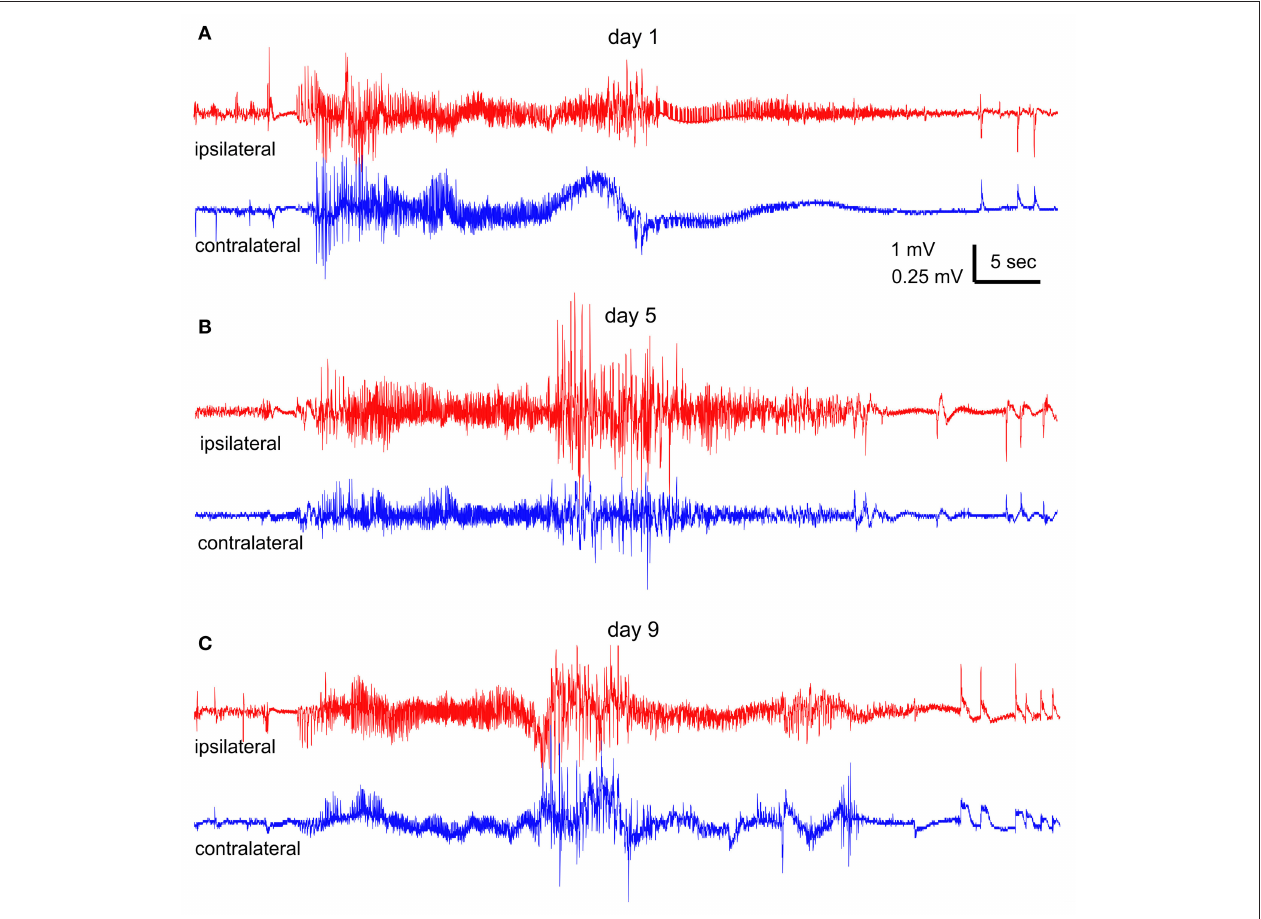
FIGURE 4 | Spontaneous hippocampal EEG discharges. Continuous EEG-webcam monitoring was conducted in an extendedly kindled mouse (#4) over 9 consecutive days. (A–C) One episode of bilateral discharges collected at the 1st, 5th, and 9th day, respectively. “Ipsilateral” (red) and “contralateral” (blue) events refereed to the site of hippocampal kindling stimulation. Note the onset time advance of ipsilateral vs. contralateral discharge in (A) . An episode of stage-5 or stage-3 motor seizure was observed in correspondence to the discharges in (B,C)